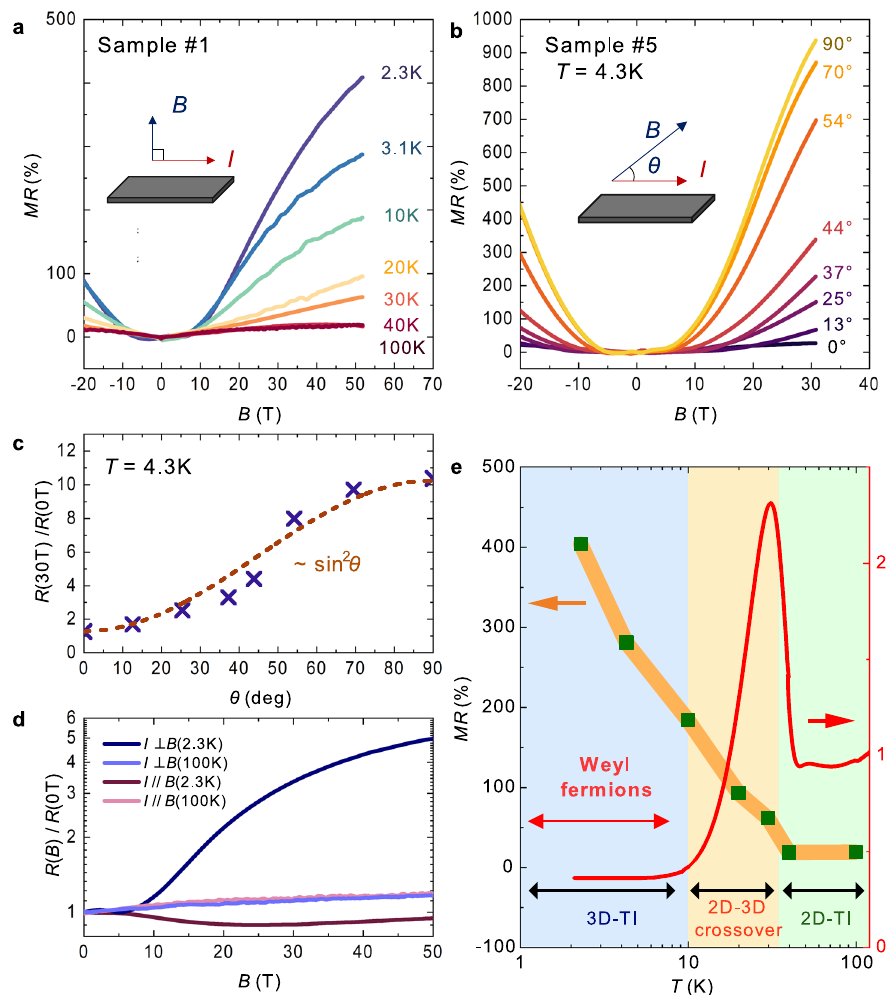
d Comparison ofMRsof Sample #1of I ⊥ B and I // B at2.3 and 100K,respectively. The strong anisotropy of MR can be observed only at low temperatures. e Temperature dependence of the magnitude of the transverse MR of Sample #1 andtheout-of-planeresistanceofSample#2.Below35K,thepositiveMRbeginsto increase, which agrees with the appearance of the surface conduction on the ab